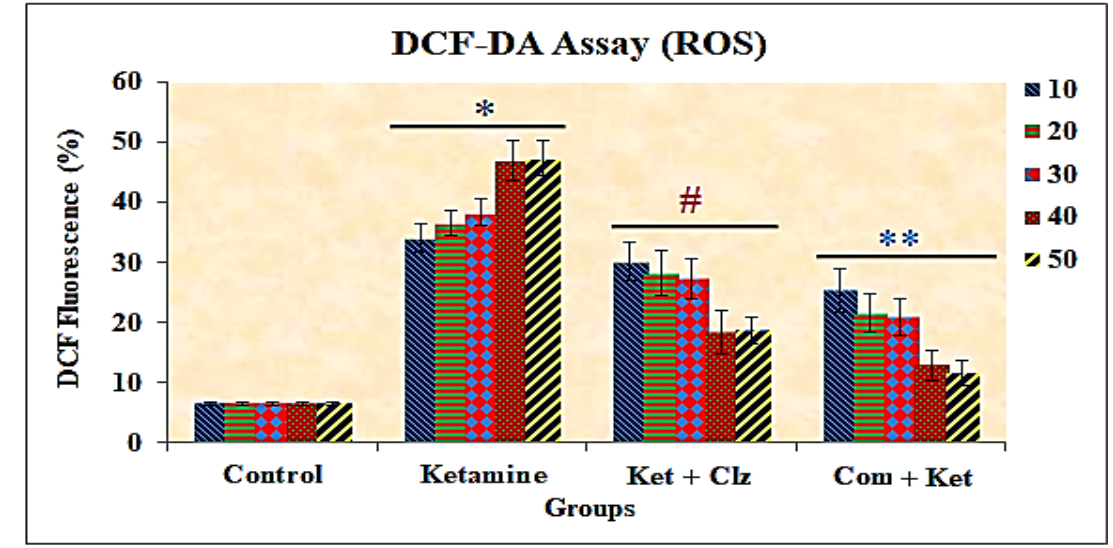
Figure 6. Protective effects of plant compound and clozapine on ROS levels in PC 12 cell lines exposed to ketamine in vitro. All the values are expressed as means ± SD of six individuals. * Significant at p < 0.05 compared with control; # and ** significant at p < 0.05 compared with ketamine treated group; 10 – 50: concentration in µg/mL of ketamine, clozapine, and compound.